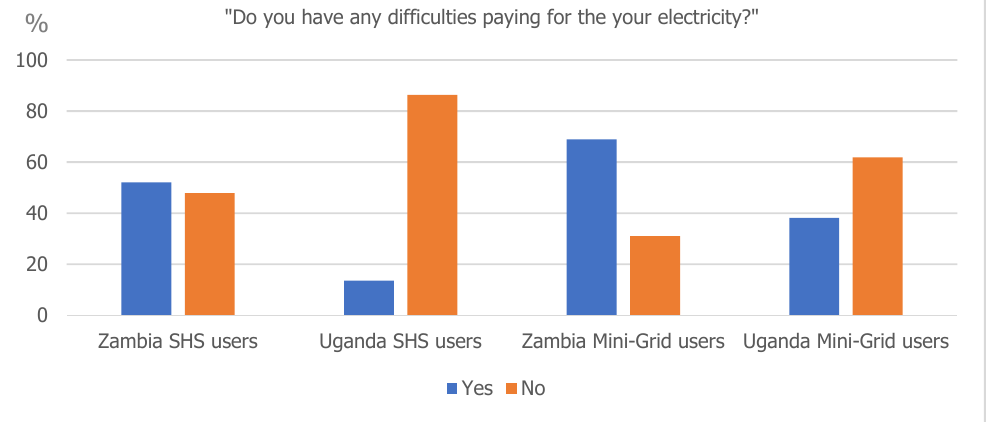
Figure 13. Difficulty in payment for electricity among various consumer subgroups; Responses in %.